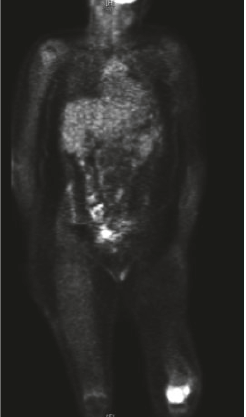
Figure 4: Fludeoxyglucose-positron emission tomography (FDG- PET), August 2009. Increased activity of FDG within the left knee (SUV max of 17.11), with physiologic distribution of FDG in the remainder of the